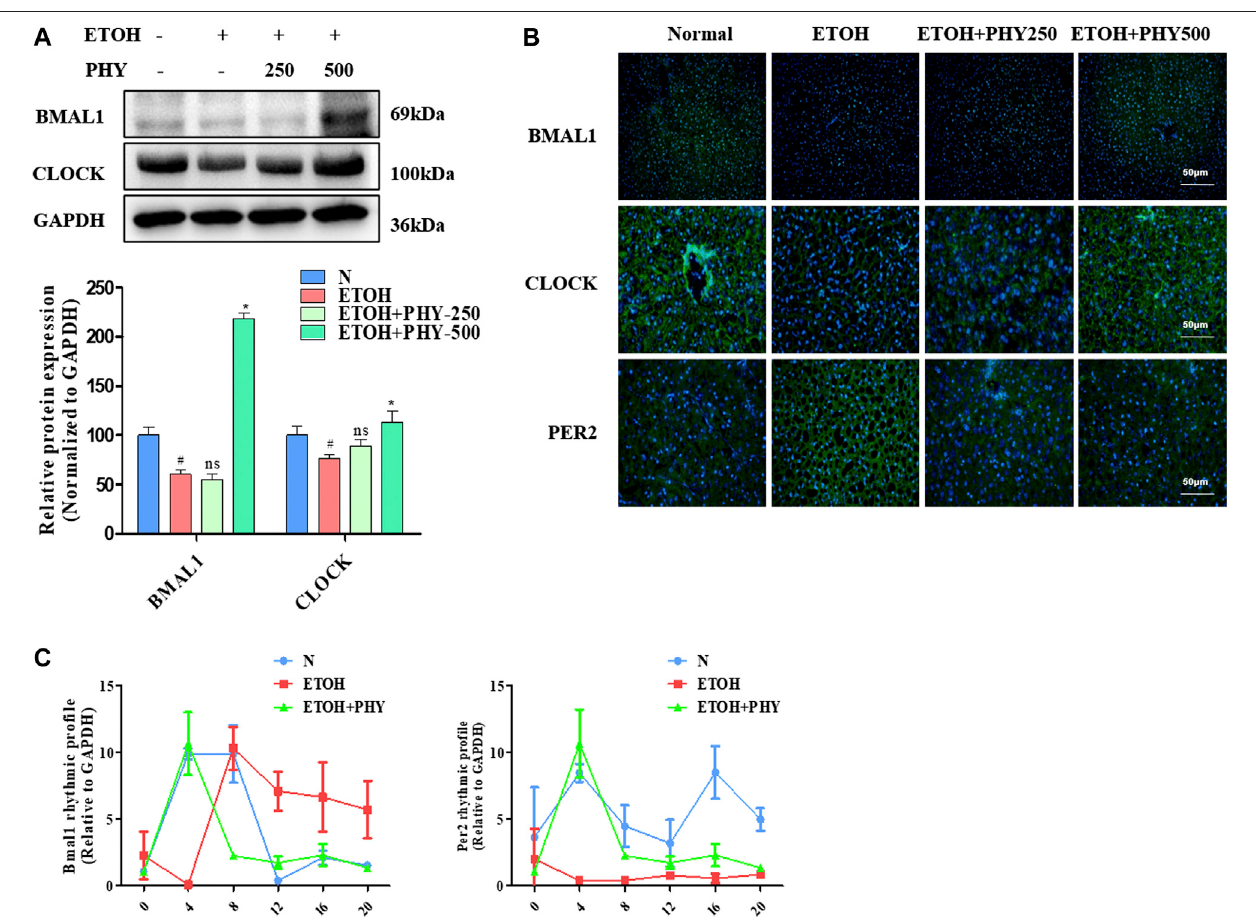
FIGURE4| Physcion improves thedisorderofthecircadianclockpathway in acute alcoholichepatosteatosis. (A) Theprotein expression ofBMAL1, and CLOCK. (B) Immuno fl uorescence staining of BMAL1, CLOCK, and PER2. (C) The mRNA expression of Bmal1 and Per2. Values signi fi cantly different from the control are indicated by hash signs ( # p < 0.05). Values signi fi cantly different from the ethanol are indicated by asterisks (* p < 0.05).